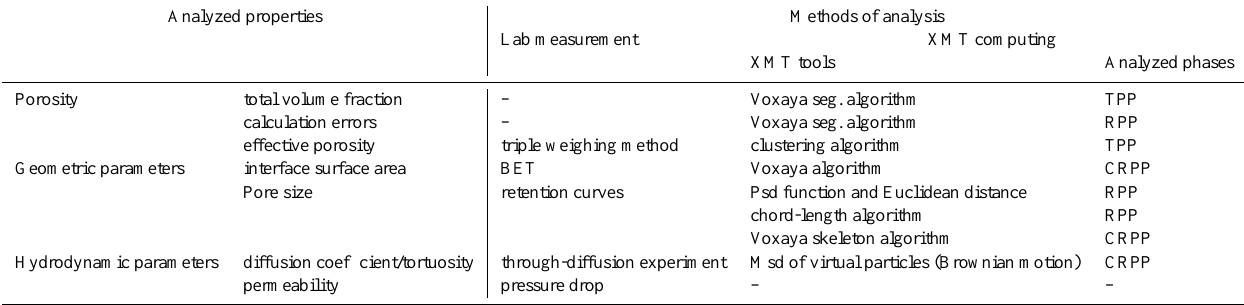
Table 1. Summary of the measured parameters and the corresponding methodologies. (seg.: segmentation, Psd: pore-size distribution, Msd: mean square diplacement, TPP: total porous phase, RPP: resolved porous phase, CRPP: connected resolved porous